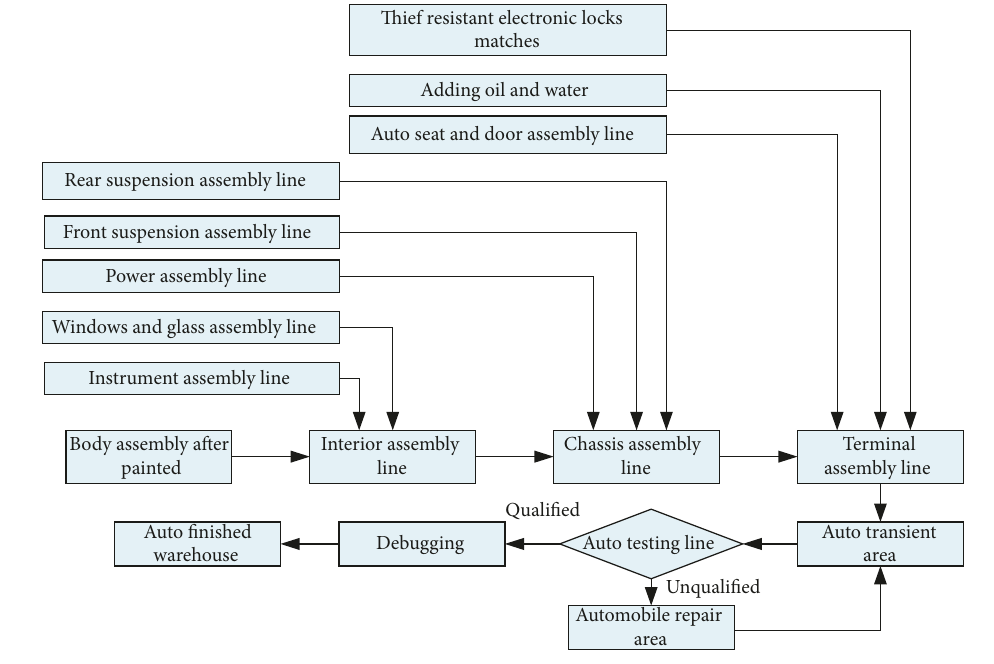
Figure 6: Automobile assembly process.